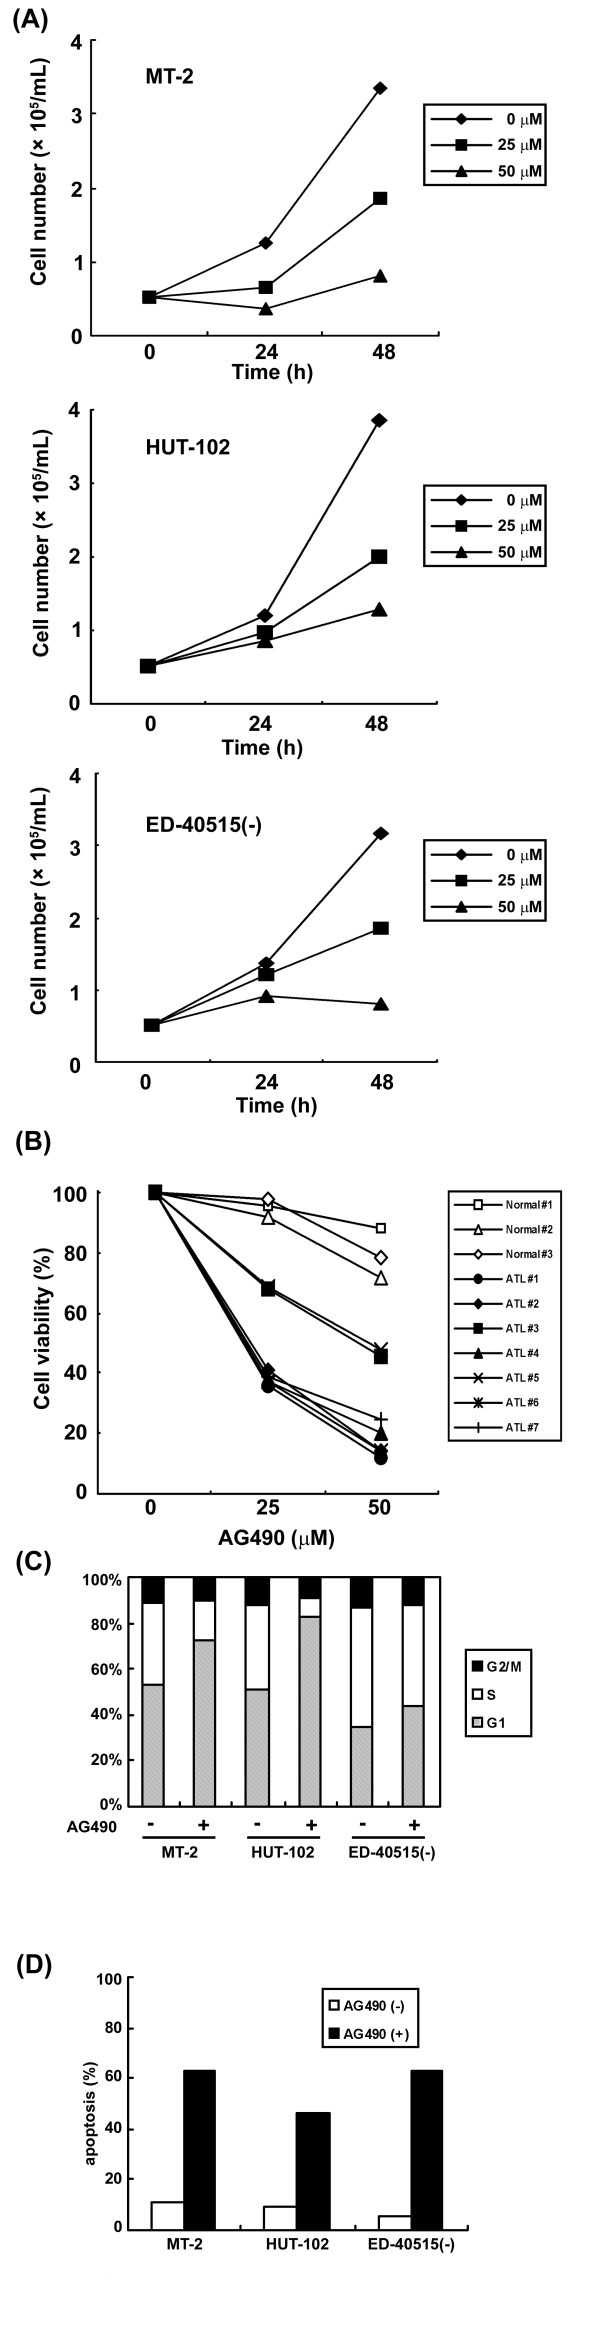
AG490 reduces cell growth of HTLV-1-infected T-cell lines and primary ATL cells. (A) HTLV-1-infected T-cell lines (5 × 104/mL) were treated with 0, 25 or 50 μM AG490 for 24 or 48 h. Cell numbers were counted in triplicate by Trypan blue dye exclusion method. Data are expressed as the mean values of viable cell numbers. (B) Primary ATL cells from seven patients (ATL #1–7) and PBMCs from three healthy donors (Normal #1–3) were treated with 0, 25 or 50 μM AG490 for 48 h. Cell growth was assessed by the WST-8 method. Data are expressed as the percentages of control (untreated cells). (C) Cell-cycle analysis of HTLV-1-infected T-cell lines treated with AG490. Cells were treated in the absence (-) or presence (+) of 25 μM AG490 for 24 h. DNA content was analyzed by flow cytometry with propidium iodide staining. G1, S and G2/M indicate the stages of the cell-cycle. Data represent mean percentages of cells at each cell-cycle from three independent experiments. (D) Induction of apoptosis in HTLV-1-infected T-cell lines by AG490. Cells were treated in the absence (open bar) or presence (solid bar) of 50 μM AG490 for 48 h and stained with Annexin-V. Apoptosis was analyzed by flow cytometry. Data represent mean percentages of apoptotic cells from three independent experiments.